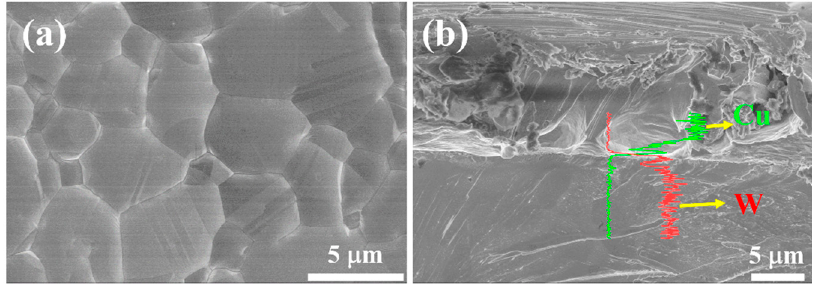
Figure 6. SEM image of nano-treated W after Cu plating for 30 min and then annealing at 980 °C for 3 h: ( a ) surface morphology, ( b ) cross-section morphology and EDS line scan image.